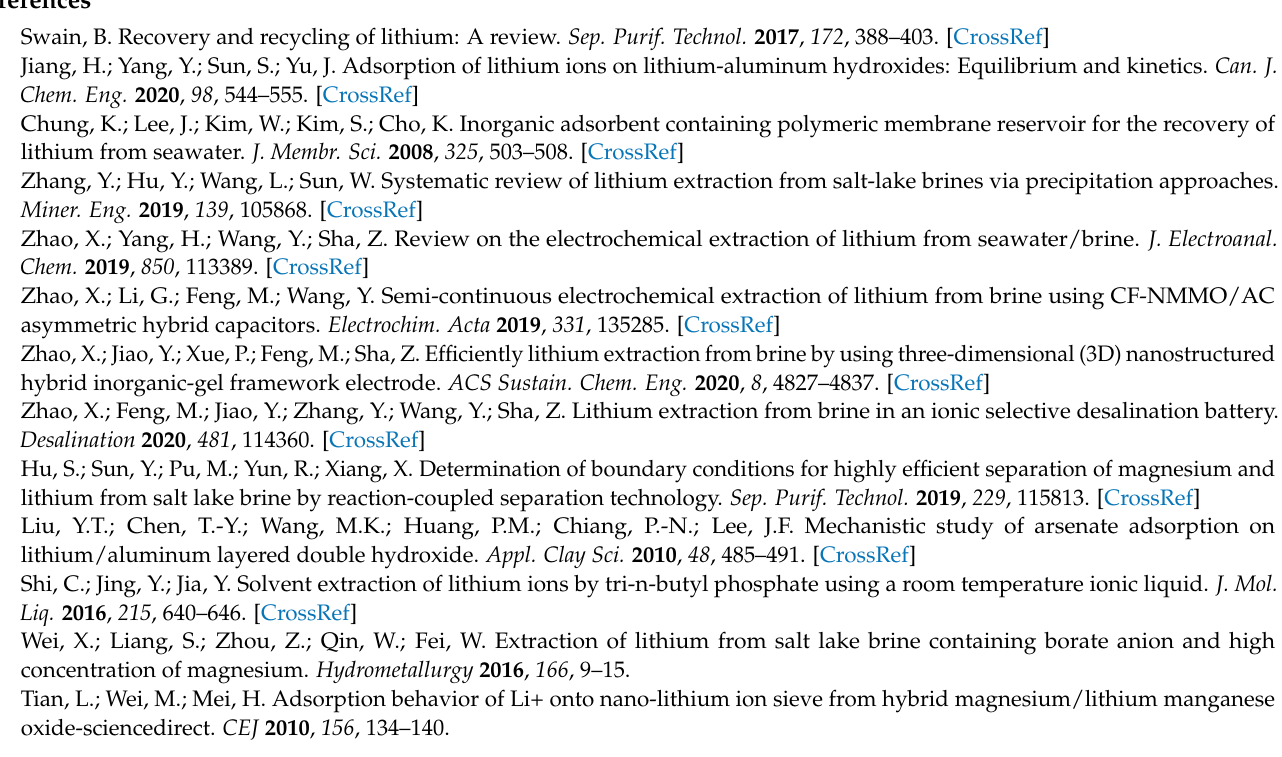
Table S2: The particle size distribution of MIL-121 under different temperature, Table S3: Preparation method and preparation time of partial aluminum-based MOF, Table S4: TGA mass loss of N-MIL-121 crystals synthesized under different conditions, Table S5: The adsorption performance test data of MIL-121 after polymerization obtained under different experimental